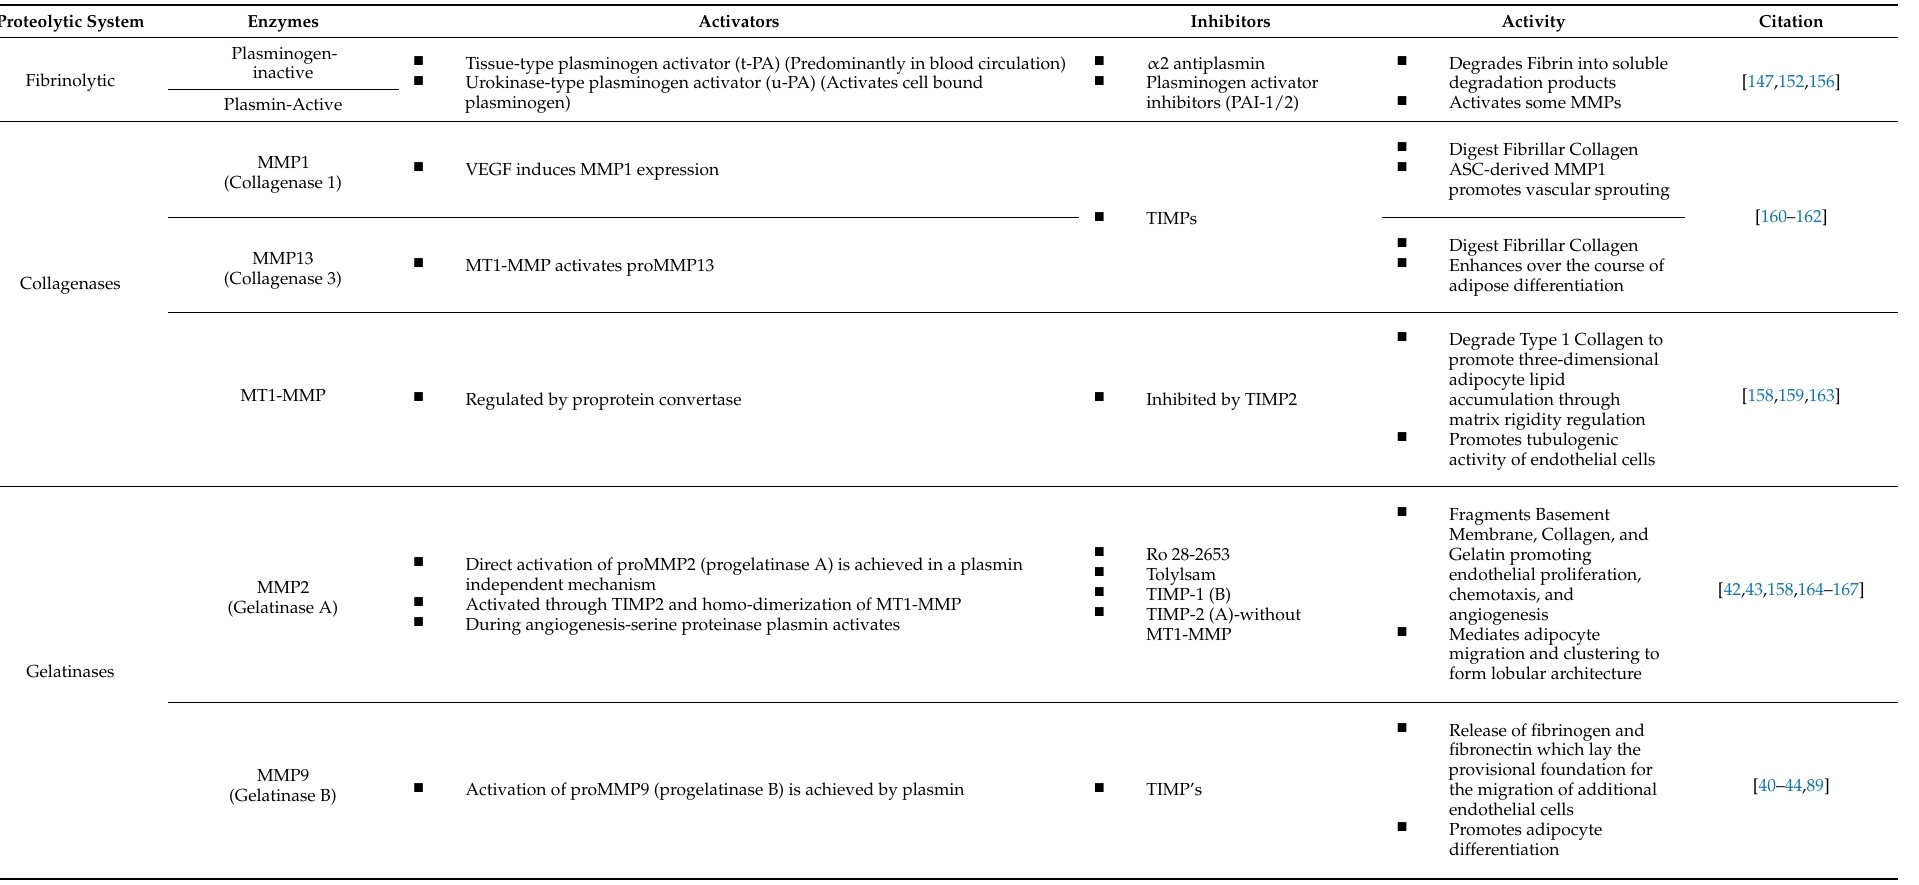
Table 1. Proteolytic Enzymes, their regulators, and downstream